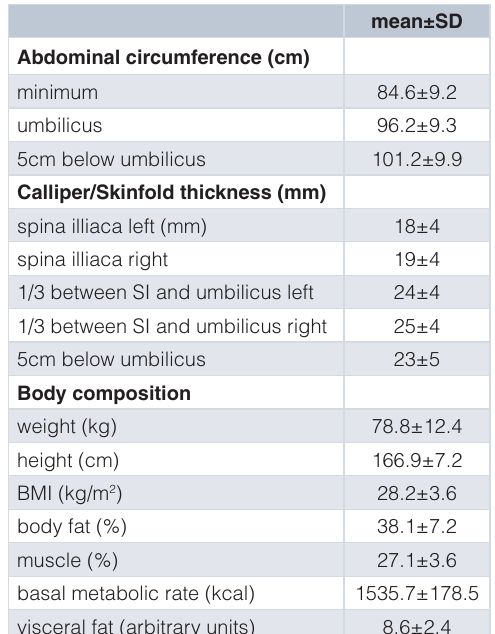
Table 1. Clinical characteristics of the study